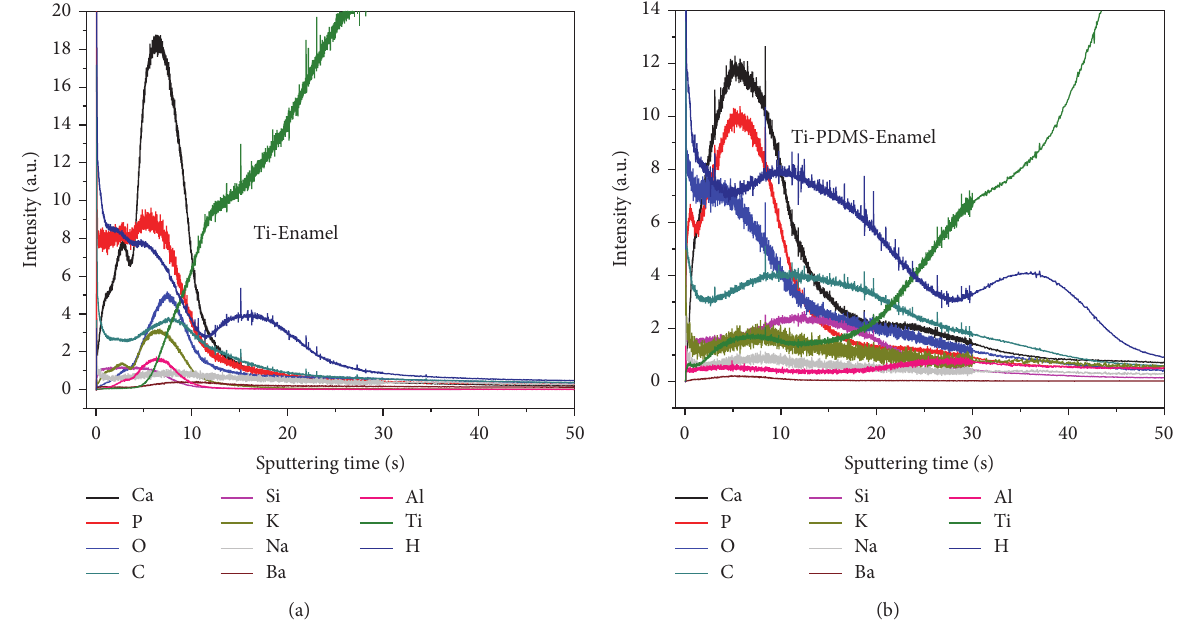
Figure 4: GDOES depth profiles of Ti-Enamel (a) and Ti-PDMS-Enamel (b) layers.